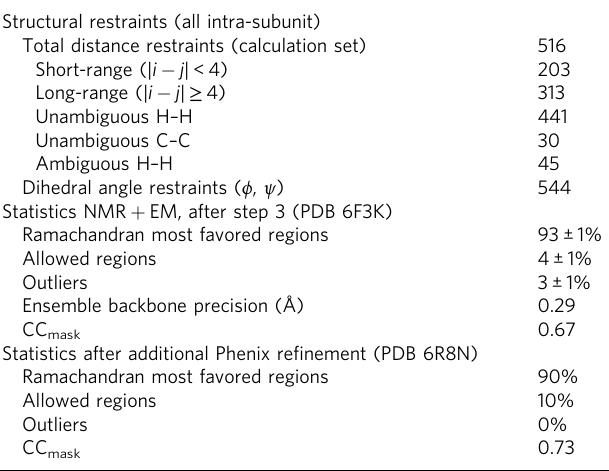
Table 1 NMR restraints and structural quality assessment Structural restraints (all intra-subunit) Total distance restraints (calculation